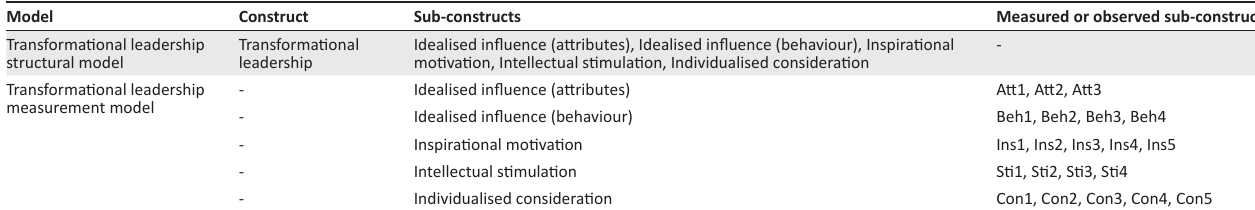
TABLE 2: Criteria for goodness-of-fit indices. Goodness-of-fit